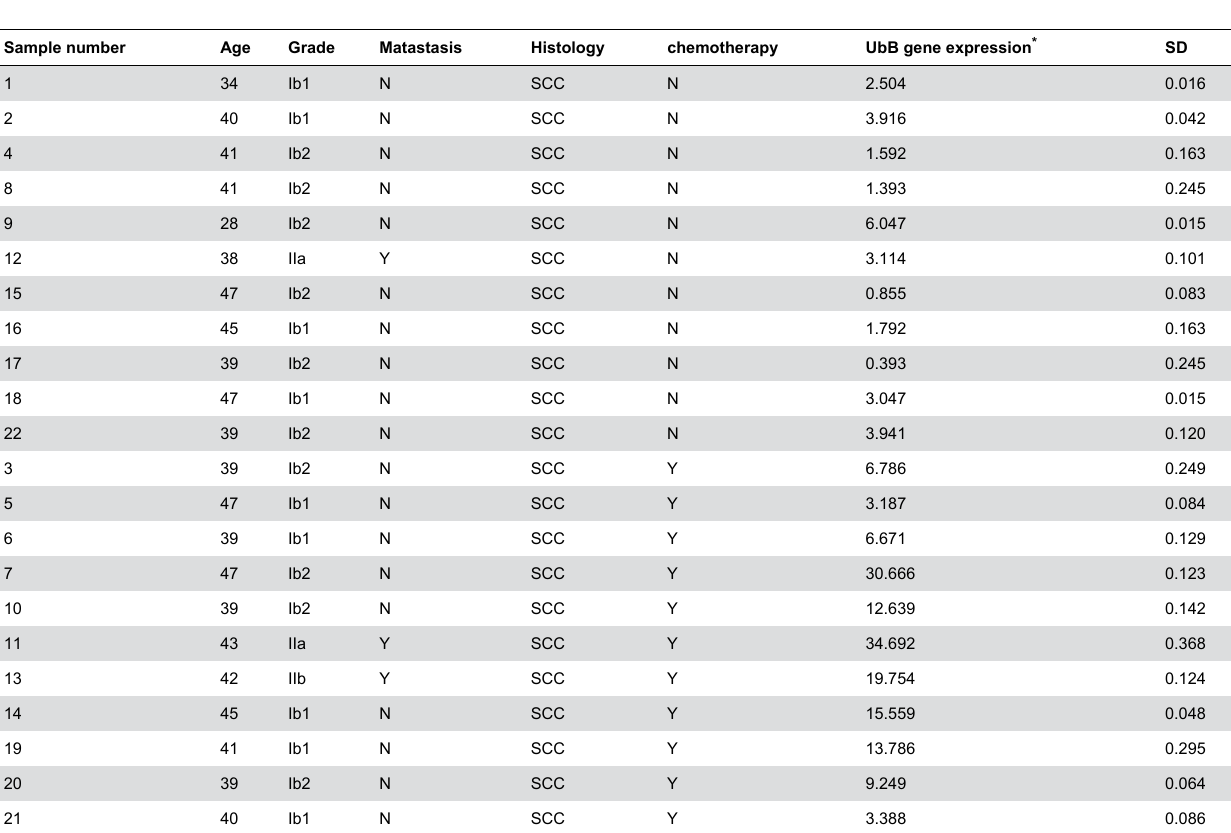
* Relative UbB mRNA expression of cervical cancer tissue samples contrast to the adjacent tissues. SCC: squamous cell carcinoma. Y: Yes. N: No. SD: standard deviation.